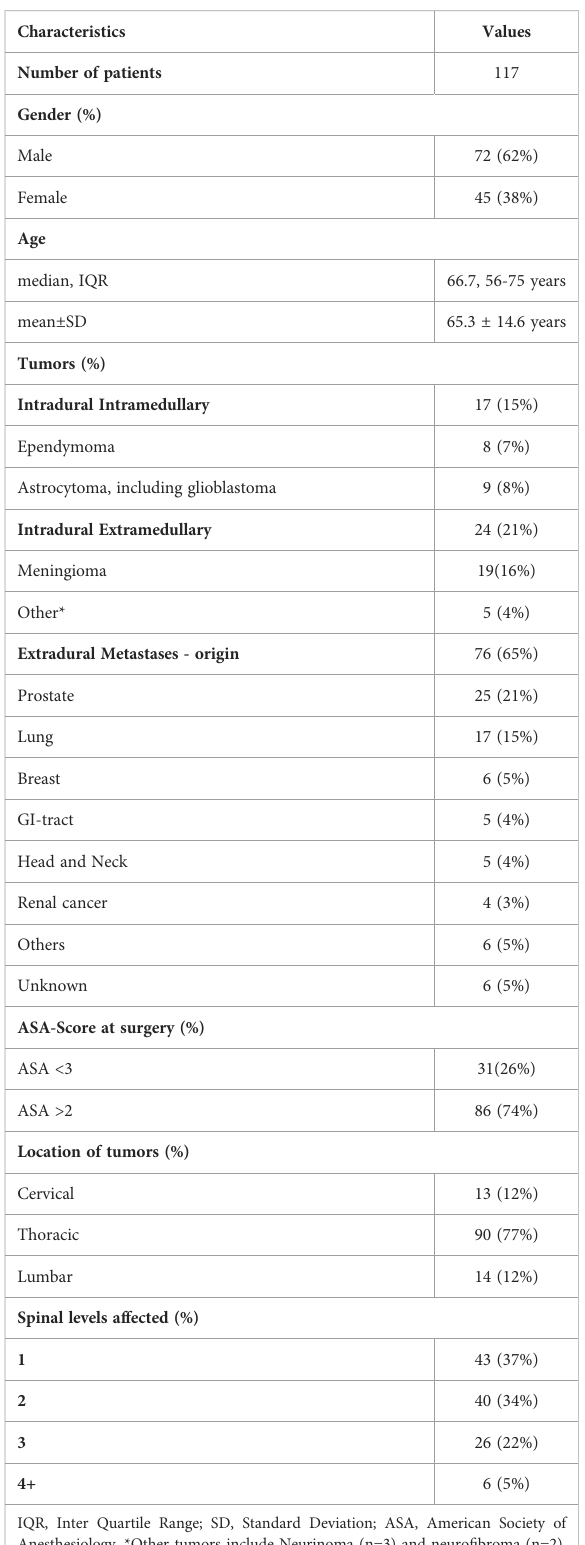
TABLE 1 Patient demographics and imaging fi